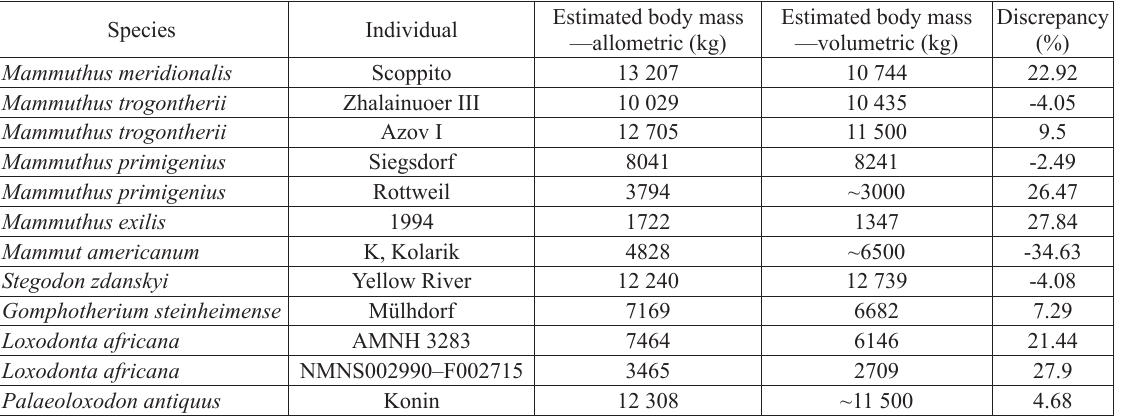
Table 4. Comparison between the allometric (Christiansen 2004) and volumetric (this paper) method for estimation of body mass from a selected sample of different proboscideans. Note that some specimens are either much heavier or lighter than predicted by the volumetric